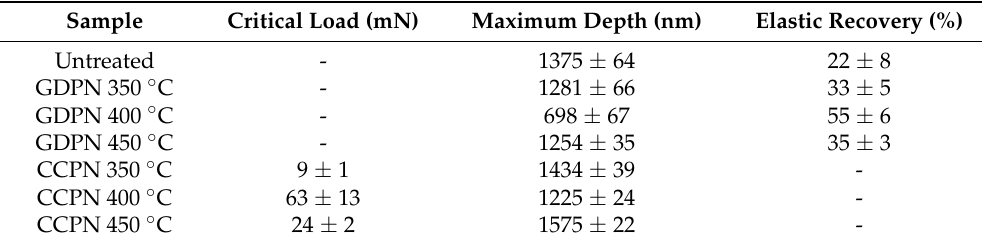
Figure 14. Nanoscratch profiles of untreated and GDPN-treated AISI 316 steel samples and micro- graphs obtained by backscattered SEM. Table 2. Critical load, maximum depth, and elastic recovery (under 200 mN load) of untreated and nitrided